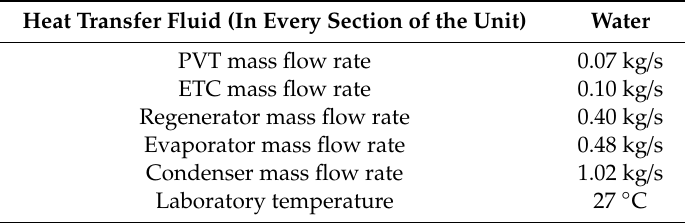
Table 3. Working conditions during